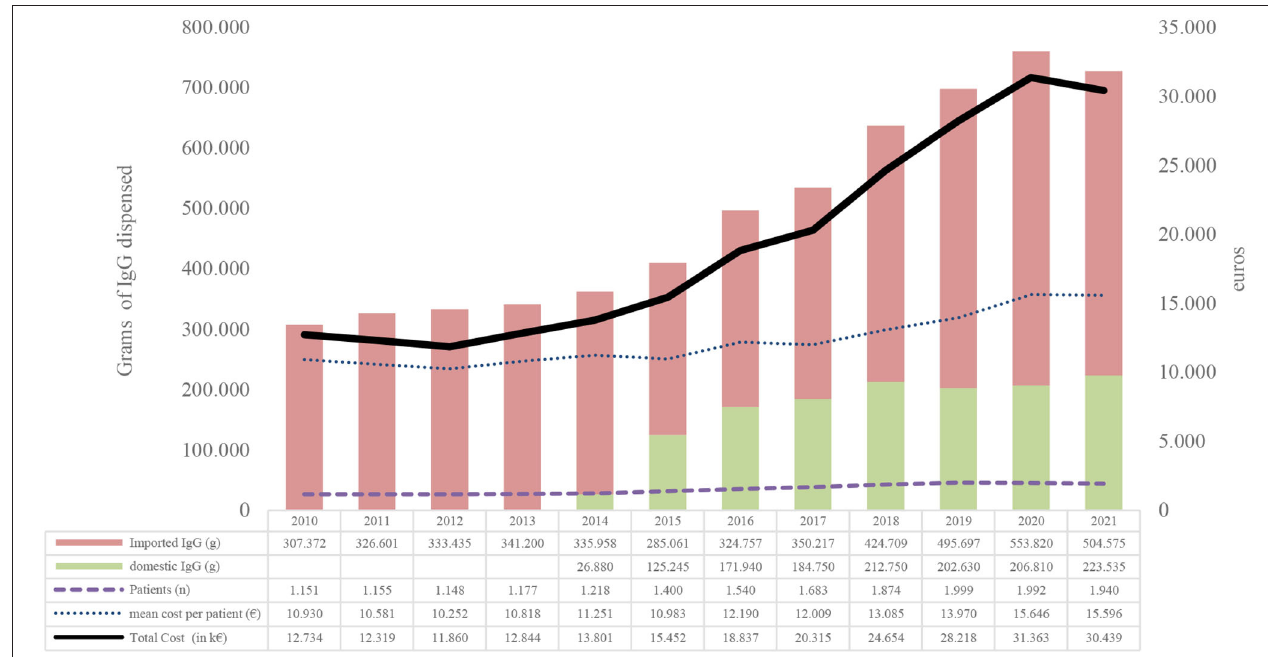
FIGURE 2 | Evolution of IgG consumption between 2010 and 2021. Source, Billing registry;Domestic IgG, immunoglobulins obtained from Catalan voluntary non-remunerated blood donor (VNRBD); Imported IgG, immunoglobulins obtained from remunerated blood donors